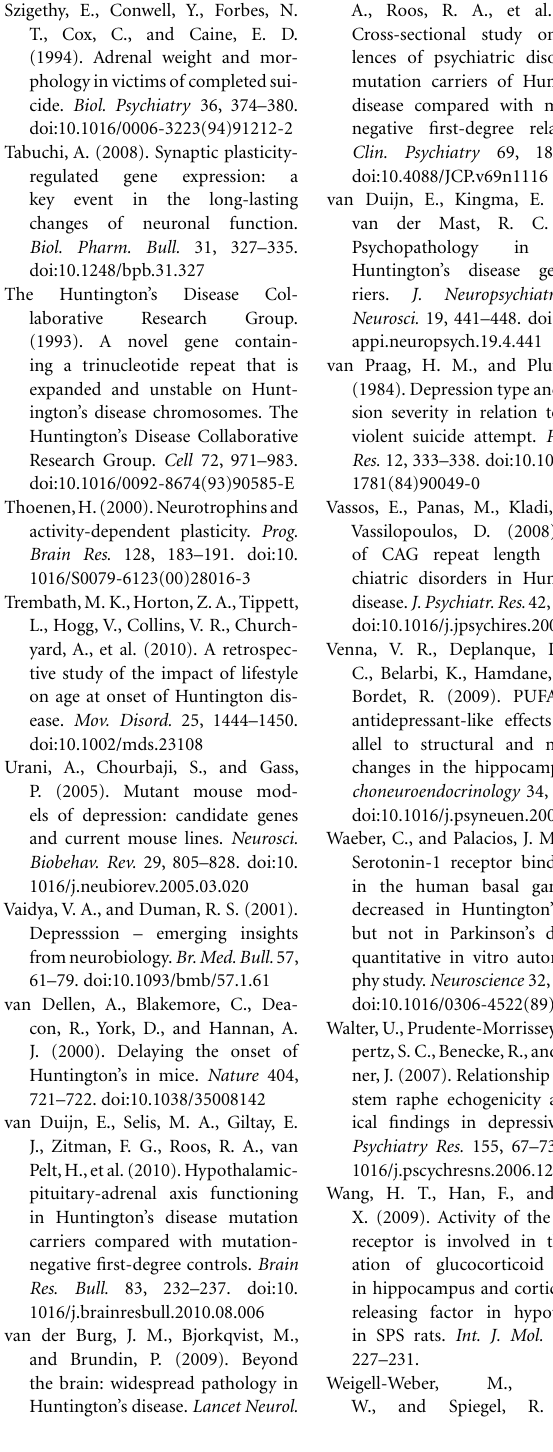
Tabuchi, A. (2008). Synaptic plasticity- regulated gene expression: a key event in the long-lasting changes of neuronal